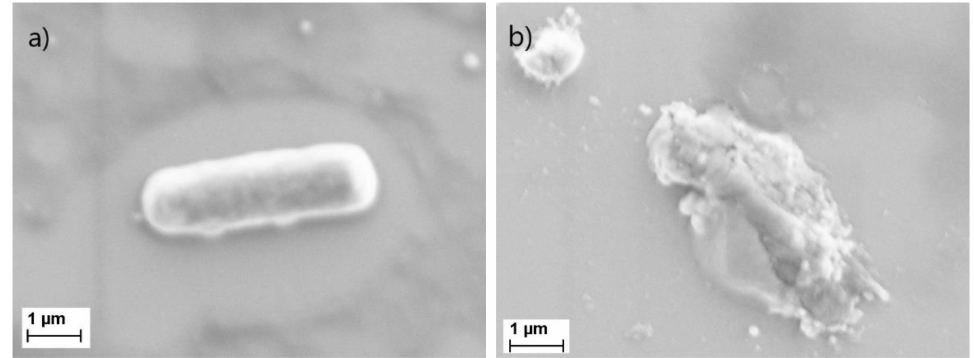
Figure 6. Scanning electron microscopy (SEM) image of ( a ) an intact B. cereus bacterium and ( b ) a B. cereus lysed